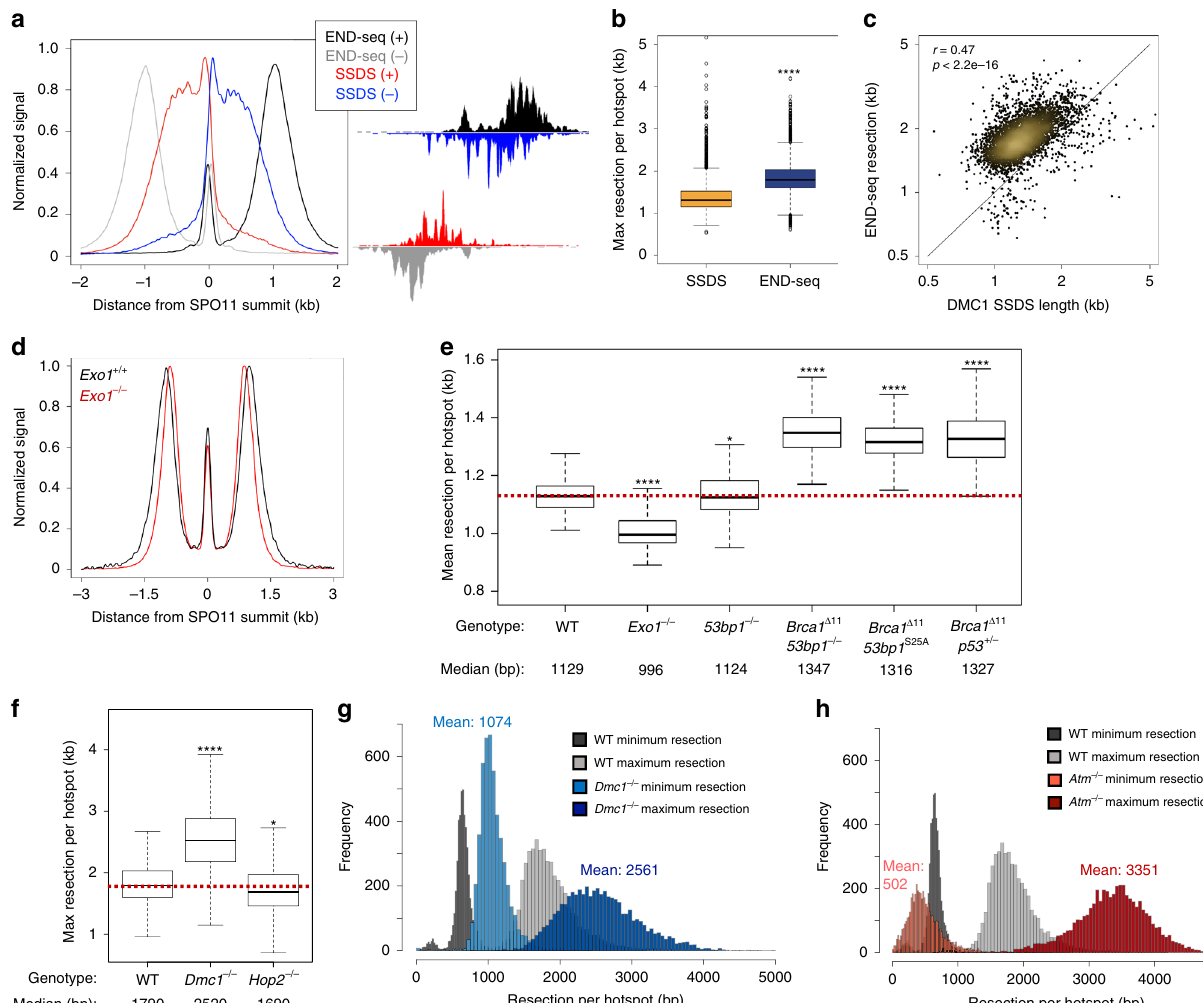
Fig. 4 END-seq accurately measures hotspot resection lengths and elucidates resection regulation. a Top ( + ) and bottom ( – ) strand distributions of END-seq and SSDS show increased resection detection by END-seq (left, signal normalized to the same height) that is evident at individual hotspots (right). b Boxplot of END-seq vs SSDS maximum resection per hotspot. **** p < 1e-10; t test. c Correlation (Pearson ’ s r ) of maximum resection endpoints detected by END-seq and SSDS. d Aggregate plot of END-seq signal in WT and Exo1 – / – spermatocytes (signal normalized to the same height) around SPO11 oligos. e Boxplots of mean resection (as de fi ned in Fig. 2c) between WT, Exo1 – / – , 53bp1 – / – , Brca1 Δ 11 53bp1 – / – , Brca1 Δ 11 53bp1 S25A and Brca1 Δ 11 p53 + / – at top 250 hotspots. * p < 0.01; **** p < 1e-10; t test with mu = 10 (mu is estimated as standard deviation of WT replicates). f Boxplots of maximum resection endpoints between WT, Dmc1 – / – , and Hop2 – / – at top 5000 hotspots. * p < 0.01; **** p < 1e-10; t test with mu = 43 (mu is estimated as standard deviation of WT replicates). g , h Histogram distributions comparing either WT and Dmc1 – / – g or WT and Atm – / – h END-seq minimum and maximum resection endpoints at top 5000 hotspots. Mean values (bp) are